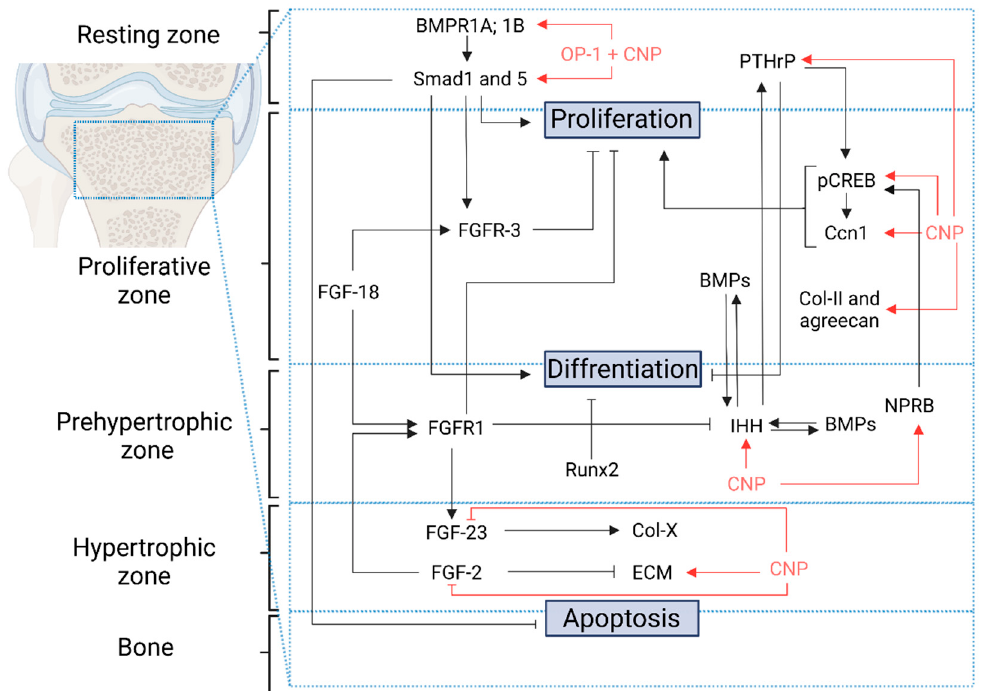
Figure 2. CNP and related bone growth involved protein expression patterns in the growth plate. BMPR1A; 1B: Bone morphogenetic protein receptors; Smad1; 5: Suppressor of Mothers against Decapentaplegic; PTHrP: Parathyroid hormone ‐ related peptide; pCREB: phosphorylated cAMP ‐ re ‐ sponse element ‐ binding protein; Ccn1: Cyclin 1 gene; Col ‐ II: Collagen type 2; BMPs ‐ Bone morpho ‐ genetic proteins; IHH: Indian Hedgehog; NPRB: NTP Receptor Type B; FGF: Fibroblast growth fac ‐ tor; FGFR:Fibroblast growth factor receptor; Runx2: Runt ‐ related transcription factor 2; Col ‐ X: Col ‐ lagen type X; ECM: Extracellular Matrix Proteins; CNP: C ‐ type natriuretic peptide. Red arrows and lines means accordingly activation or inhibition by CNP.